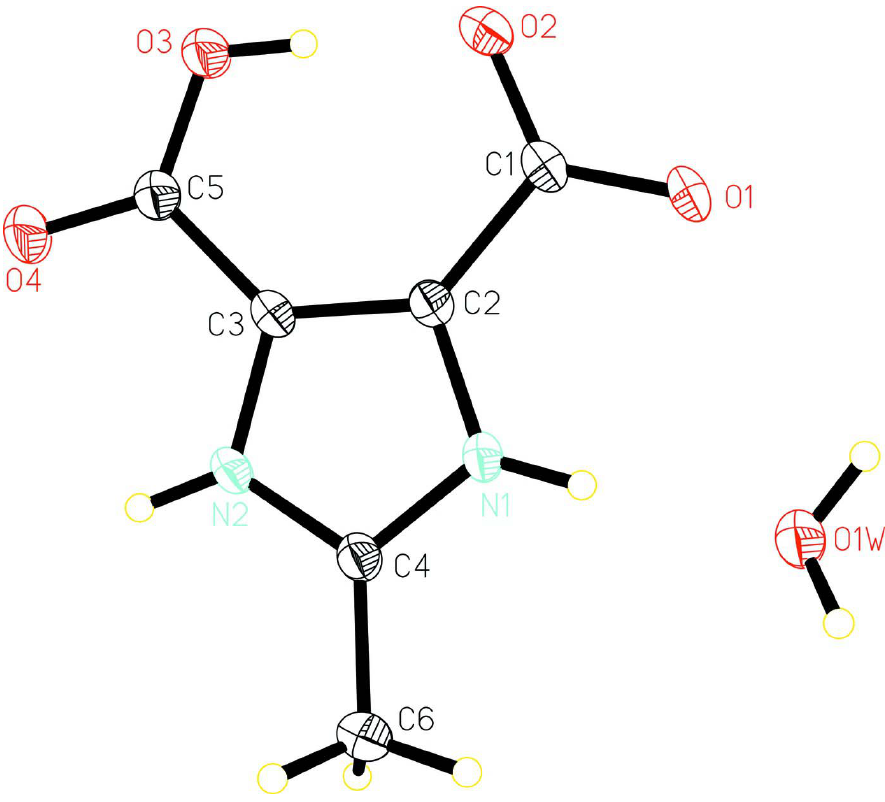
Figure 1 The molecular structure of the title compound, with displacement ellipsoids drawn at the 30% probability level. Hydrogen atoms are drawn as spheres of arbitrary radius.